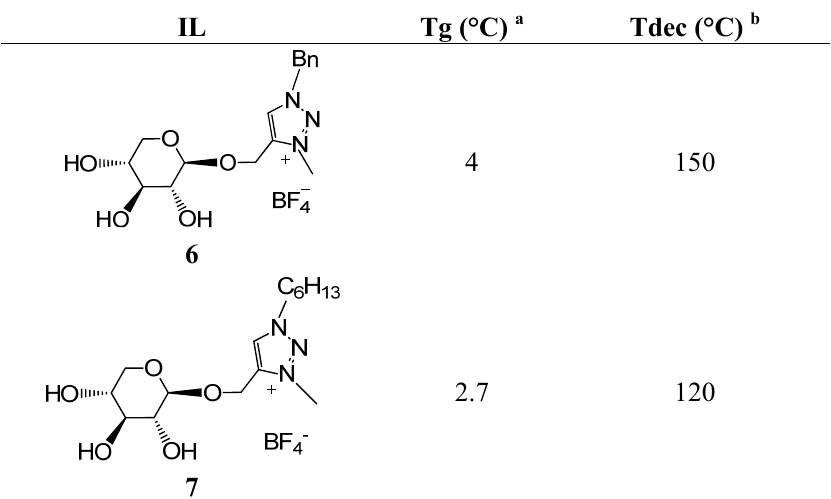
Table 1. Glass transition and decomposition temperatures of ILs 6 and 7 .